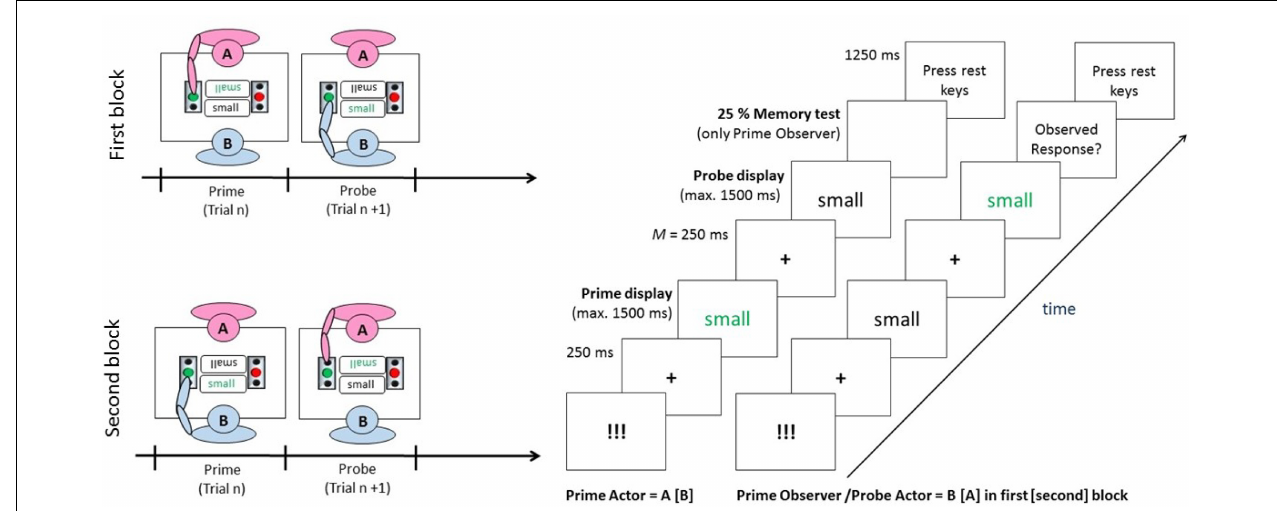
FIGURE 1 | Schematic overview of the experimental setup for participants A and B (left side) and exemplary prime-probe sequence from each participant’s perspective (right side). In the first block, participant A was prime actor and participant B was prime observer/probe actor. In the second block, this assignment was reversed, meaning that participant B was prime actor and participant A was prime observer/probe actor. Pairs were always opposite-sex interaction partners who were either romantically involved with each other (“romantic partner” condition) or were both in a romantic relationship with someone else (“stranger” condition). Assignment of males (blue figures)/females (pink figures) to the roles of prime actor vs. observer was random. Stimuli are not drawn to